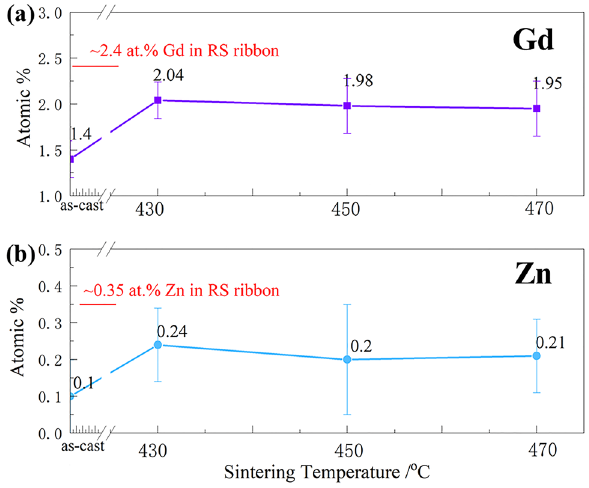
Figure 8. Gd and Zn contents of the solid solution in sintered bulks at different temperatures: ( a) Gd; ( b) Zn.